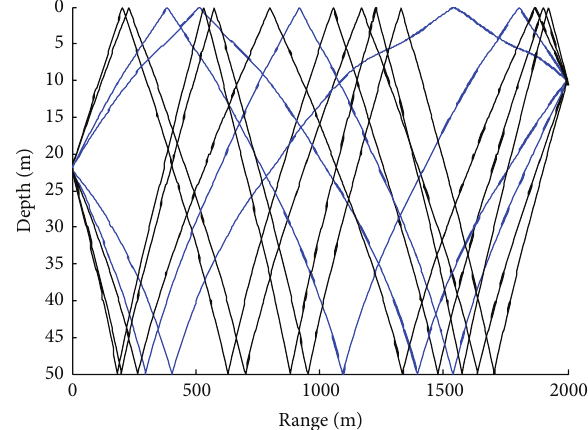
Figure 4: Eigenray of the multipath channel.